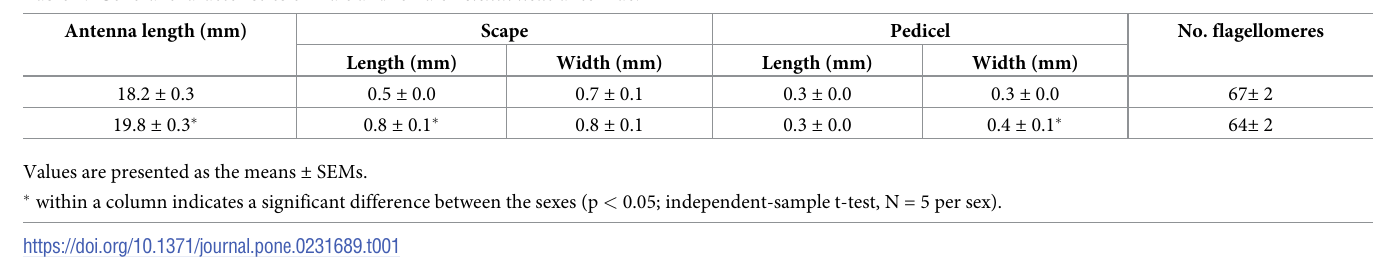
Table 1. General characteristics of male and female Telchin licus